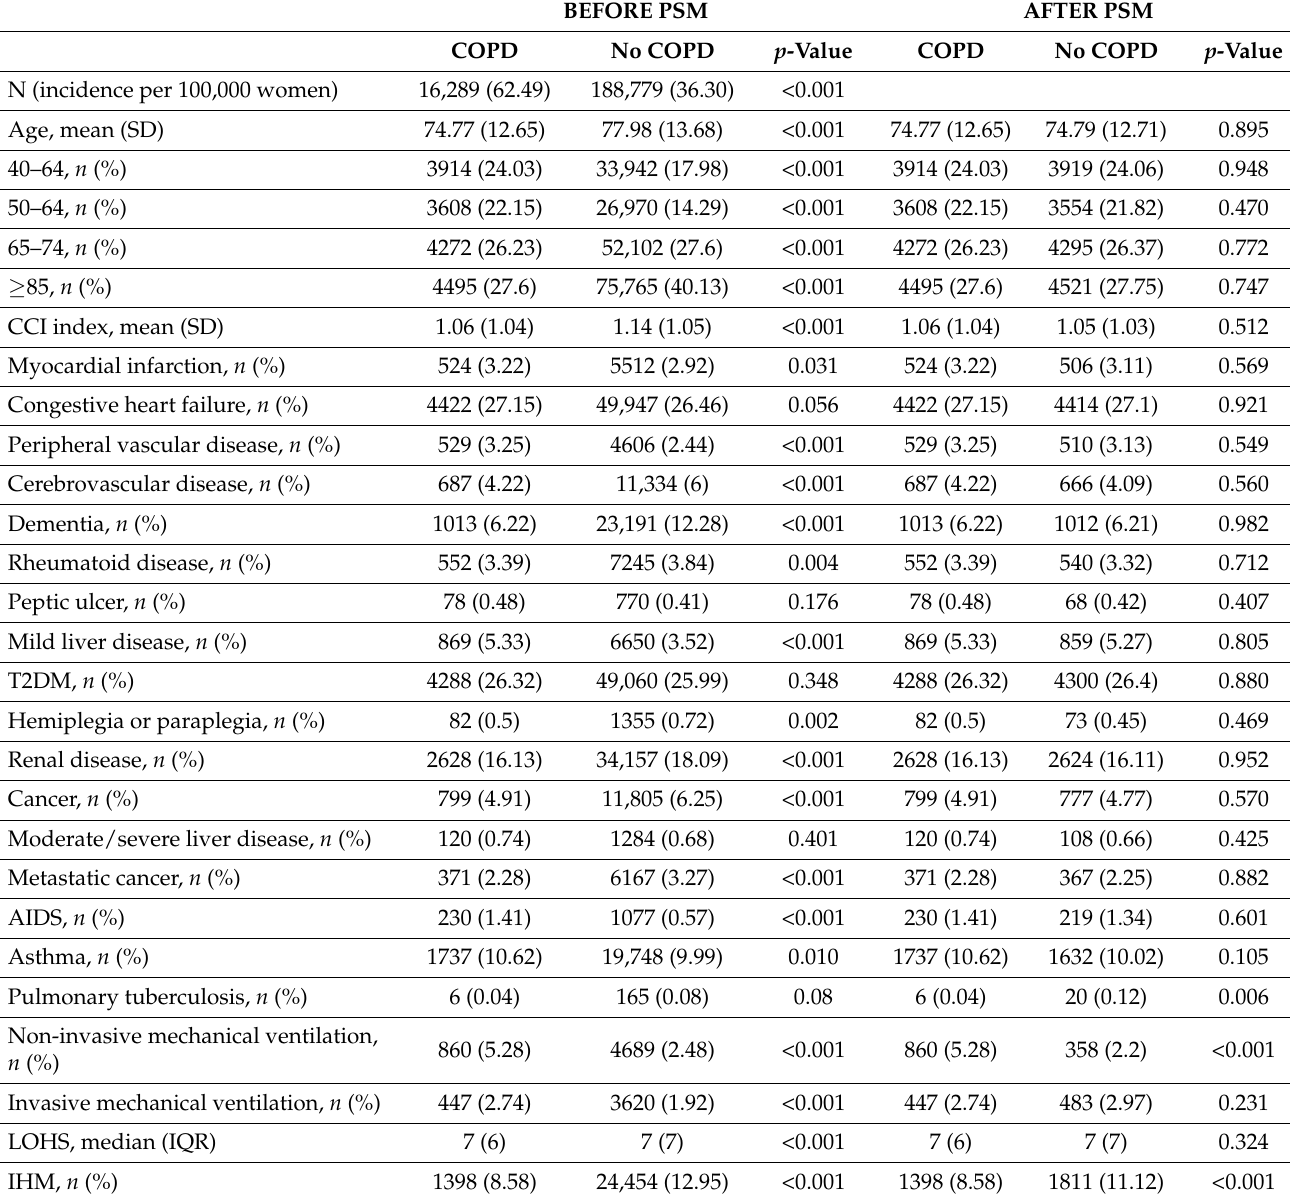
Table 2. Incidence, age distribution, Charlson comorbidity index, concomitant diseases, and hospital outcomes for women admitted to Spanish hospitals from the year 2016 to 2019 with community-acquired pneumonia according to presence of chronic obstructive pulmonary disease. Results before and after propensity score